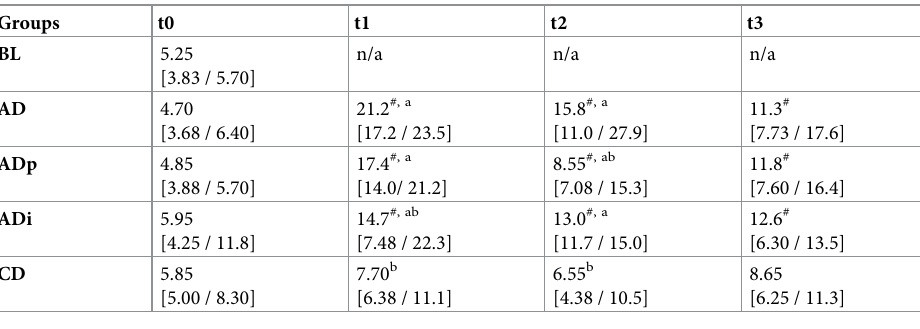
Bile acids concentrations are presented as medians and [25th / 75th] percentiles in μ mol/L. # ■ Different symbols indicate significant differences within a row (time-point differences in a group). ab Lowercase letters indicate significant effects within a column (group differences at one timepoint). Significant differences are identified by P values � 0.05 using Kruskal–Wallis test with Bonferroni correction. BL, baseline group (n = 8); AD, group fed atherogenic diet (n = 10); ADp, group fed atherogenic diet + pectin (n = 10); ADi, group fed atherogenic diet + inulin (n = 10); CD, group fed conventional diet (n = 10); n/a, not